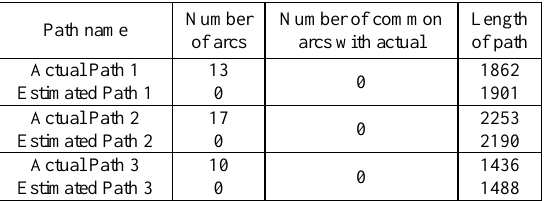
Table 1. Results of evaluation of the direct line method